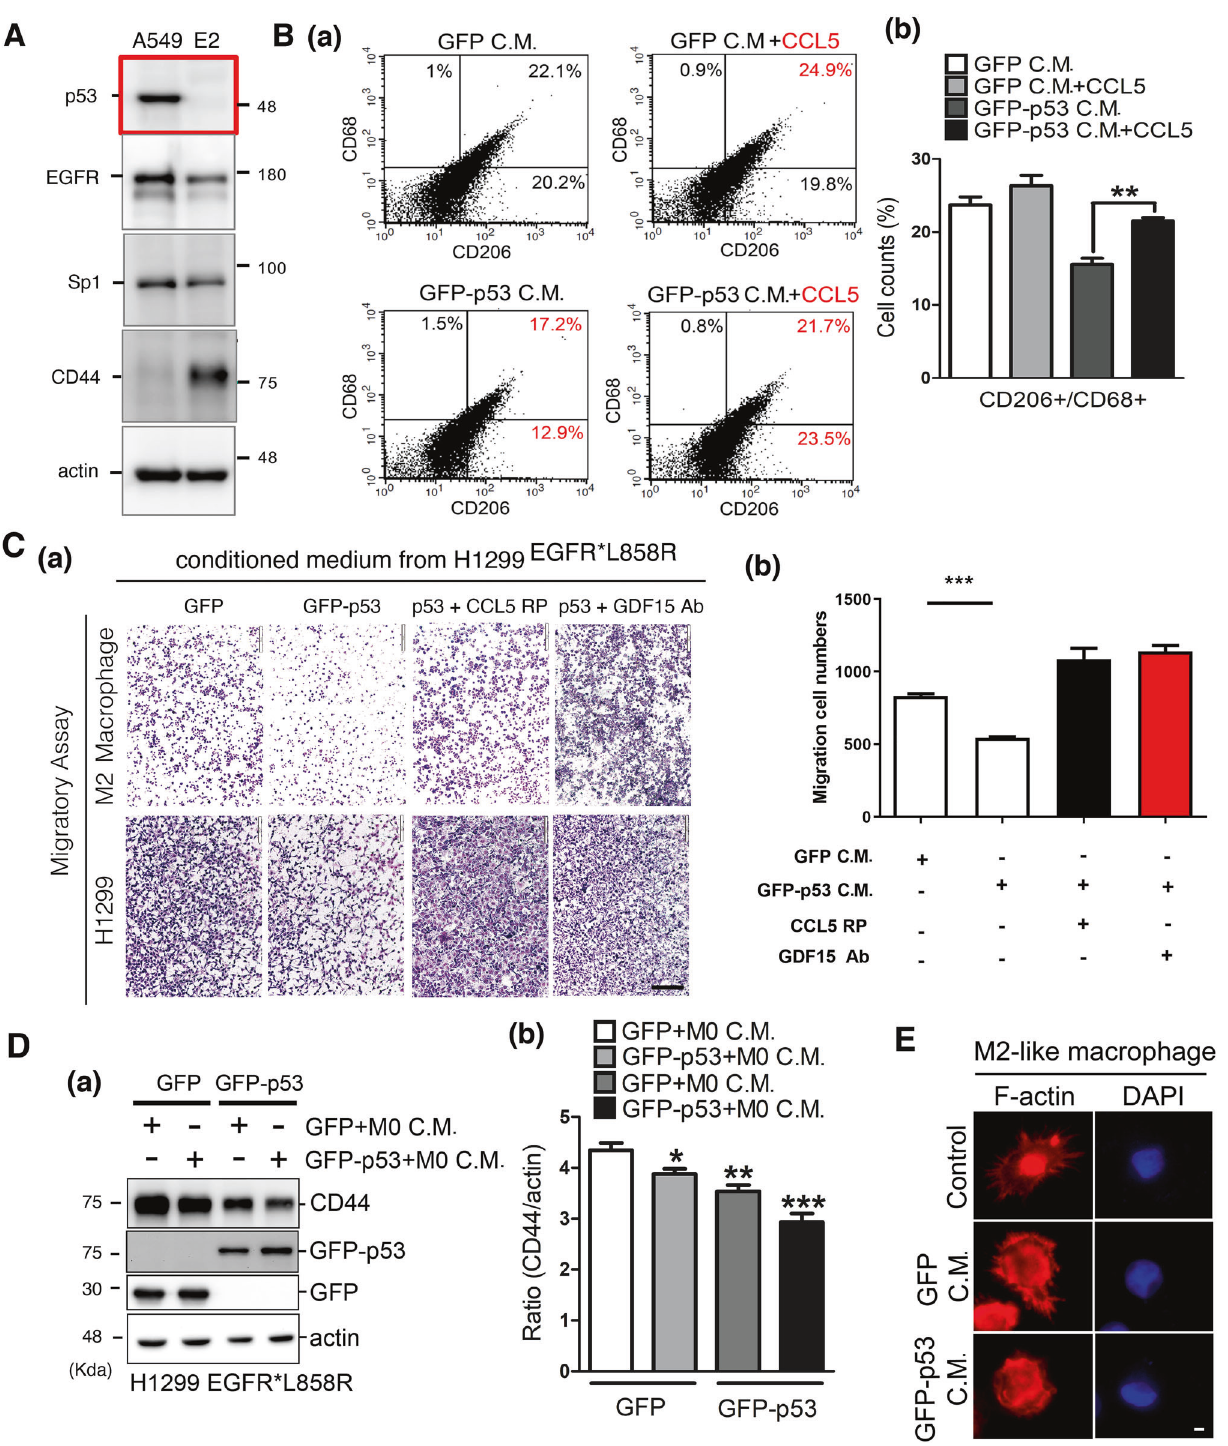
Fig. 6 E2-mediated inhibition of p53 regulates CCL5 and GDF15 to modulate macrophage differentiation. The levels of p53, EGFR, Sp1, CD44, and actin in A549 and E2-treated A549 cells were studied by western blotting with the indicated antibodies ( A ). THP-1 cells were treated with conditioned medium from H1299 L858R cells with or without GFP-p53 expression and recombinant CCL5 protein treatment; subsequently, the differentiation of M2 macrophages was studied by fl ow cytometry with anti-CD68 and anti-CD206 antibodies ( B ). The migratory abilities of M2 macrophages ( C , a , upper panel) and H1299 lung cancer cells ( C , a , lower panel) in the presence or absence of conditioned medium from H1299 L858R cells with or without GFP-p53 expression and treated with recombinant CCL5 protein (RP) or a GDF15 antibodies were studied by chamber assays ( C ). The levels of CD44, GFP-p53, GFP, and actin in H1299 L858R cells with or without GFP-p53 expression were studied by Western blotting ( D ). The morphology of M2 macrophages in the presence or absence of conditioned medium from H1299 L858R cells with or without GFP-p53 expression was studied by immuno fl uorescent assays with anti-F-actin antibodies ( E ). After three independent experiments were completed, the results were quantitated, and the statistical assays were performed by t tests; * P < 0.05, ** P < 0.01, *** P <